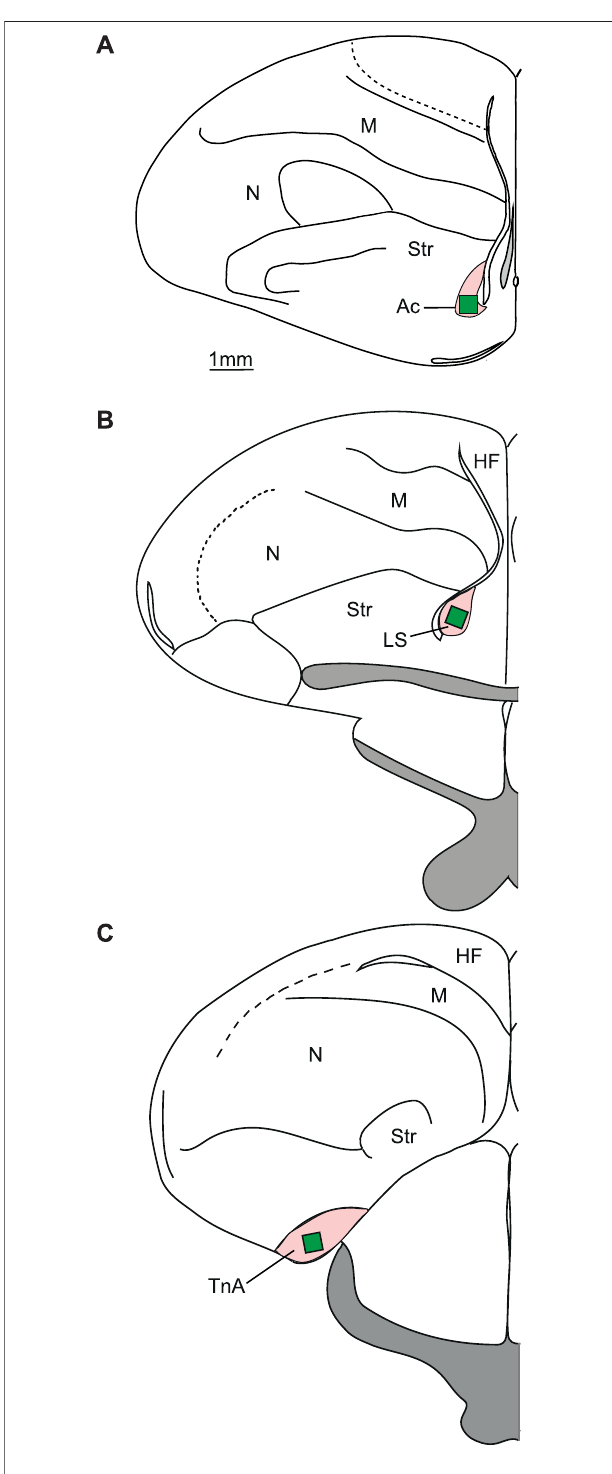
FIGURE2| Typicalplacementsofcellcountingzones(greenrectangles)in theregionsofinterest(pink). (A) Schematicrepresentationofacoronalsectionat the levelofthenucleusaccumbens. (B) Coronalsection atthe levelofthelateral septum. (C) Coronal section at the level of nucleus taeniae of the amygdala. TnA — nucleus taeniae of the amygdala; LS — lateral septum; Ac — nucleus accumbens; HF — hippocampal formation; M — mesopallium; N — nidopallium; Str -